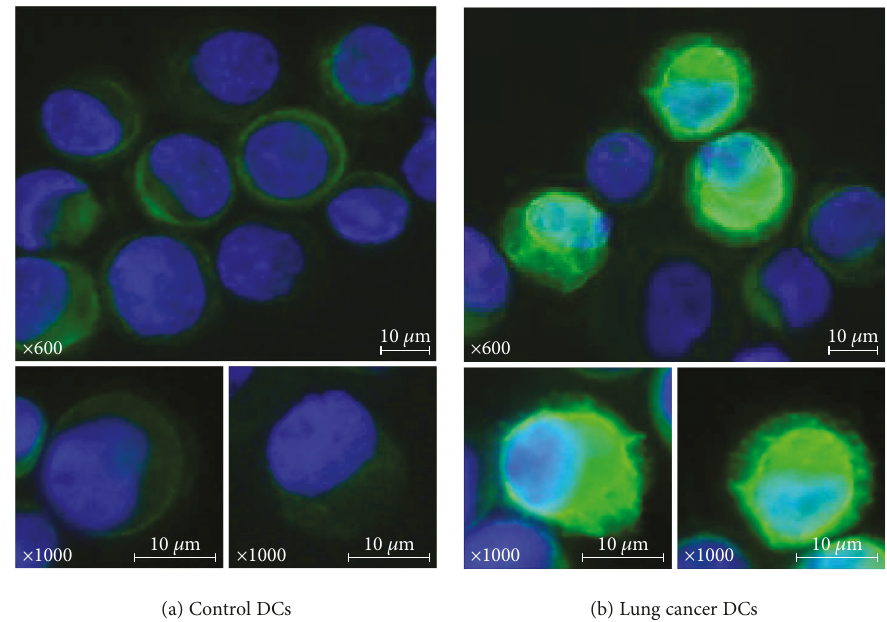
Figure 6: DC lipid accumulation. DCs isolated from the peripheral blood were stained using BODIPY 650/665 and con fi rmed under a light microscope. (a) Control DCs showing only slight fl uorescence. (b) Stage IV lung cancer DCs showing strong fl uorescence. Fluorescence microscopy photographs of DCs from representative cases were